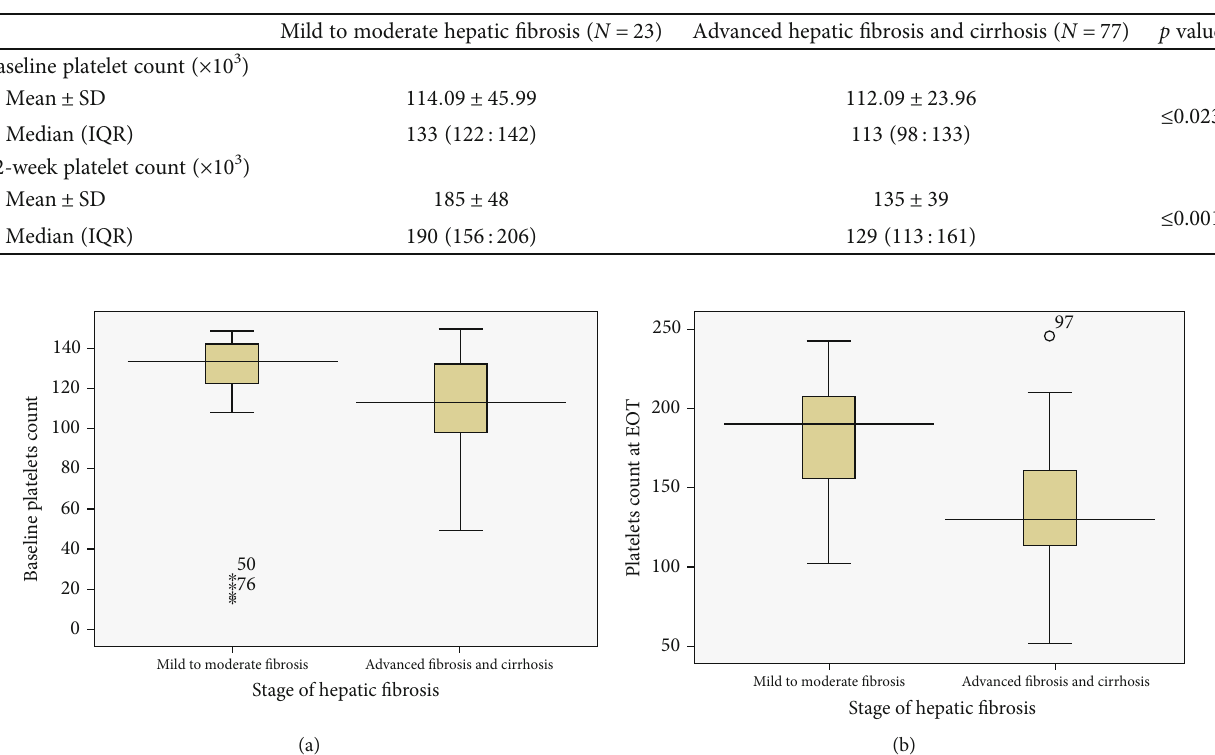
Table 3: Platelet count in relation to di ff erent stages of hepatic fi brosis.